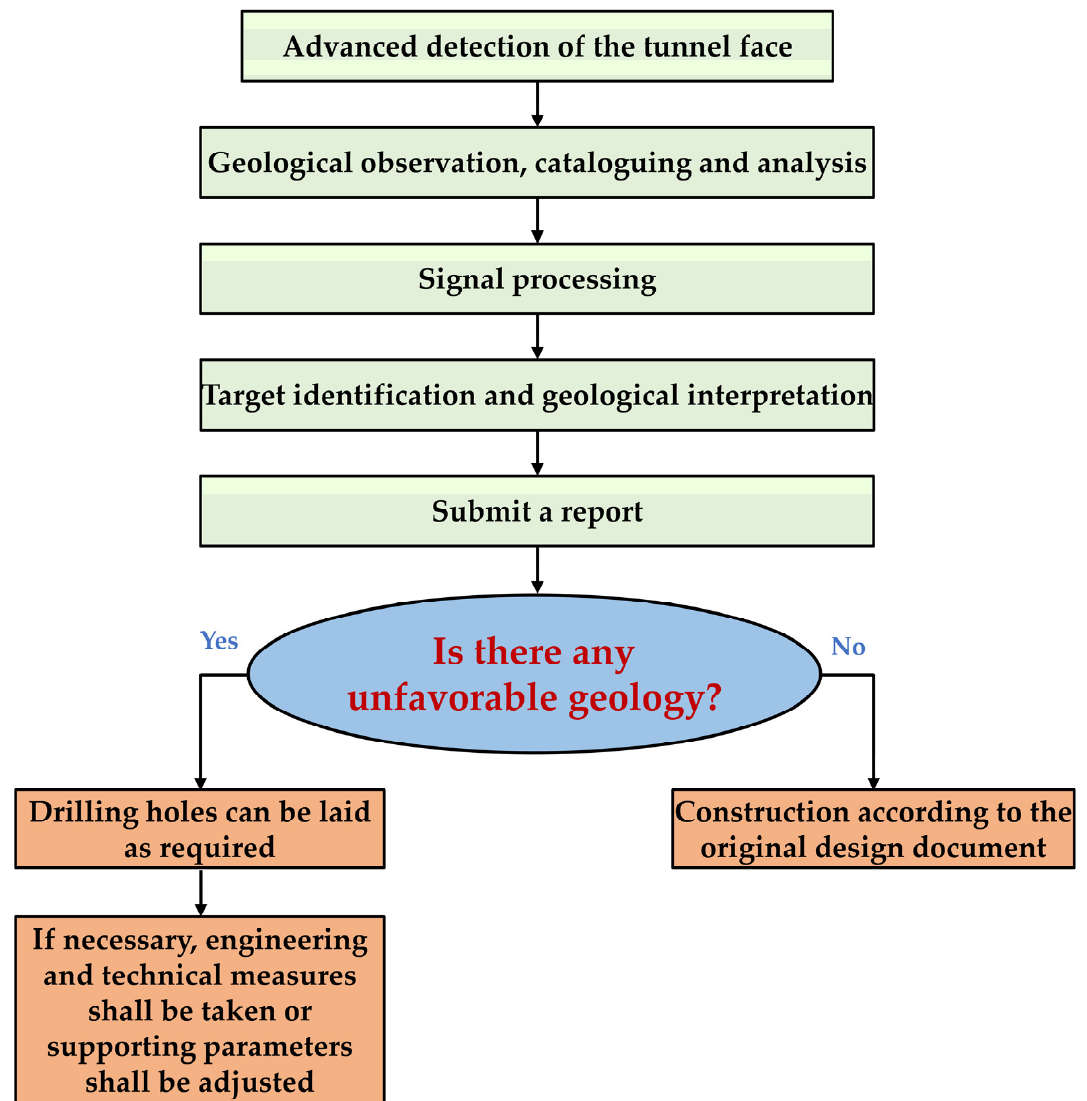
Figure 2. Advanced geological prediction process.